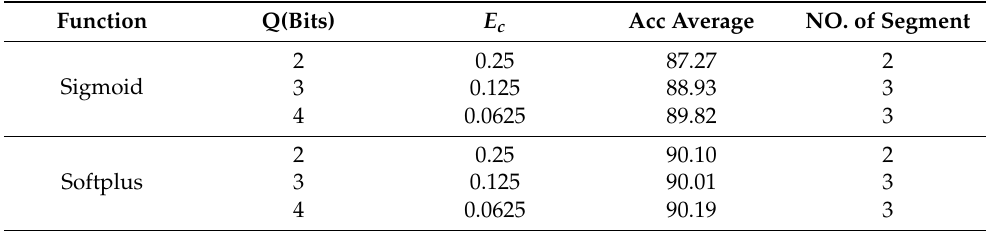
Table 4. Effect of bit width of data on classification accuracy.